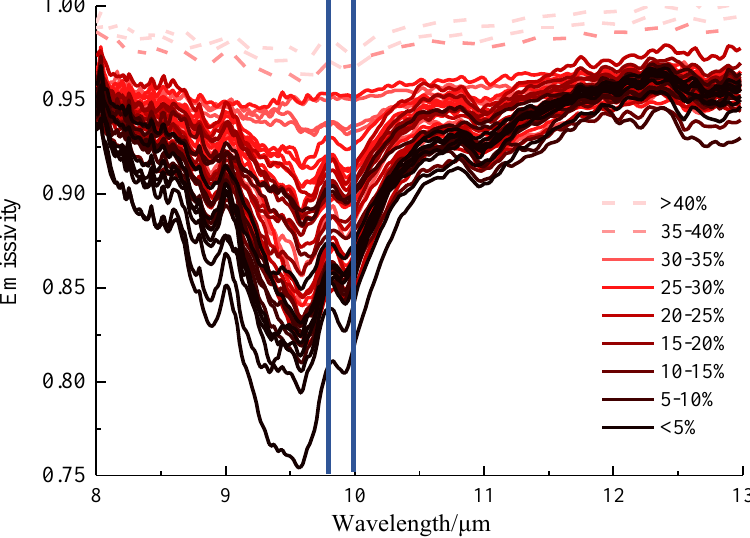
Figure 4. Thermal infrared spectra of 42 coal gangue and three coal samples.